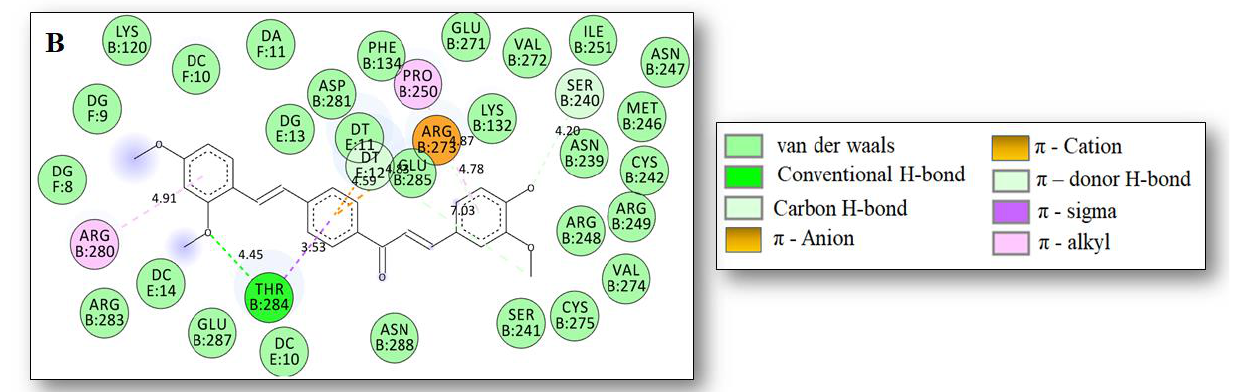
Figure 11 . ( A ) Superposition of the best docked conformation of p53-modulators SCH529074 (ma- genta) and NSC194598 (green) and 3e (orange) into the open L1/S3 pocket DNA-binding site of p53 protein. Double helix of DNA is represented in two-color (blue and red). ( B ) 2D protein – ligand plot interaction for 3e into the p53 DNA-binding domain.